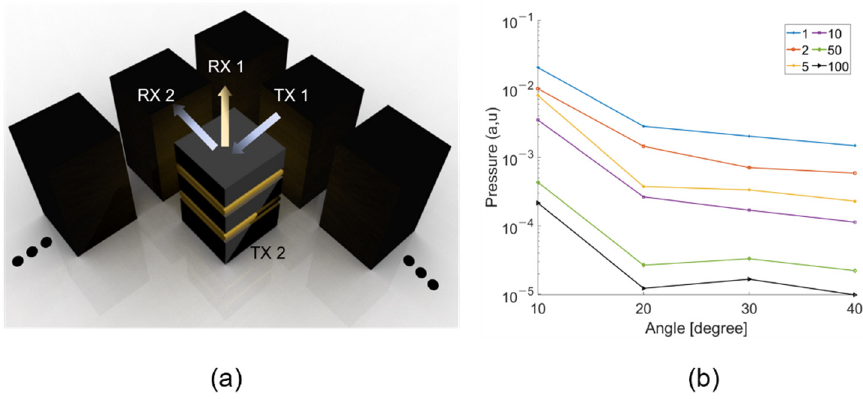
Figure 15. Perpendicular pressure referring to the number of transducers in an array. ( a ) array schematic ( b ) perpendicular pressure.